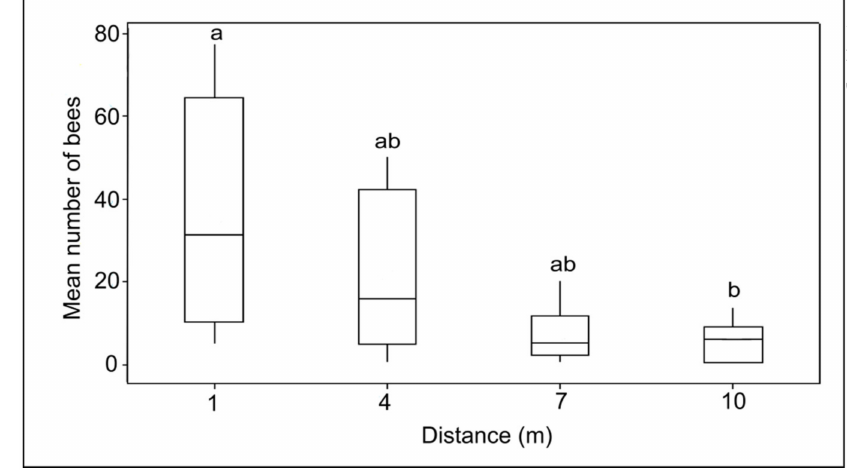
Figure 5. Mean number of Hetotrigona itama visiting feeders at different distances: 1 m, 4 m, 7 m, and 10 m. The boxes show the interquartile range (IQR); the horizontal line in the box represents the median value of the data. Whiskers are lines running outside of the box to the maximum and minimum values of the sample. The same letter indicates no significant difference, (Kruskal–Wallis test, p > 0.05, N = 10 trials).